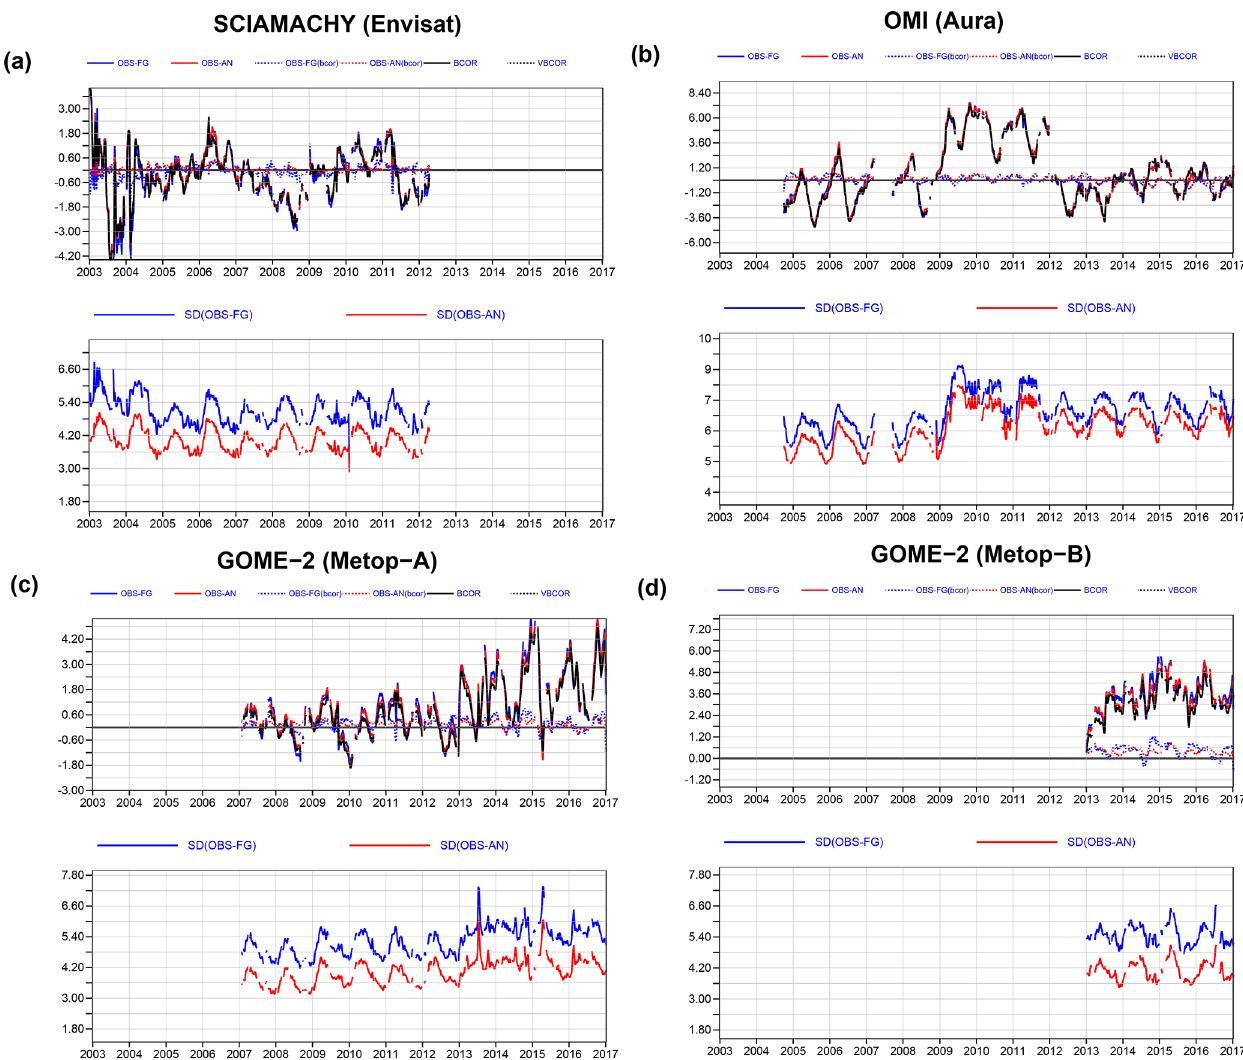
Figure 6. Time series of global mean monthly mean TCO3 departures (top plots) and standard deviations of departures (bottom plots) of (a) SCIMACHY, (b) OMI, (c) GOME-2A and (d) GOME-2B. The red lines show analysis departures, the blue lines first-guess departures, black lines bias correction, and dotted red and blue lines the bias corrected analysis and first-guess departures. Values are in DU. More information about departures can be found in the